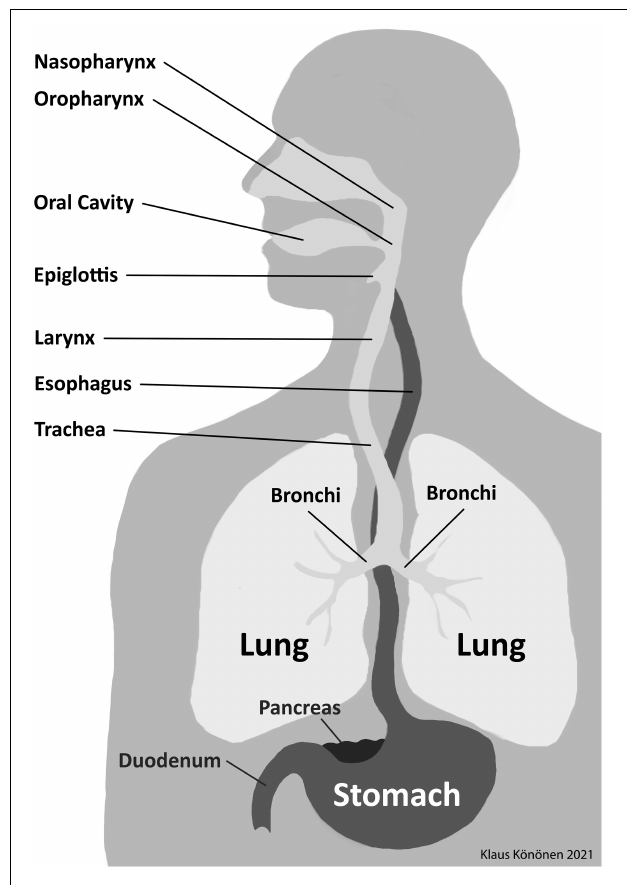
FIGURE 1 | The anatomy and potential habitats in the aerodigestive tract in